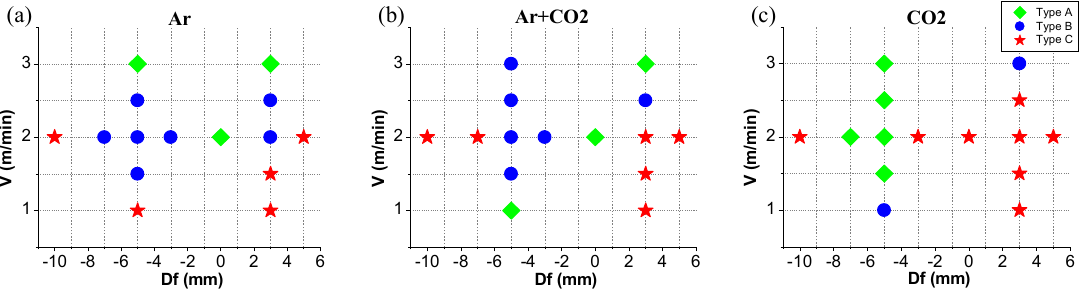
Figure 3. Distribution of weld appearance types under different shielding gases (green diamond is Type A weld joint, blue dot is Type B, red star is Type C): ( a ) in Ar; ( b ) in Ar + CO 2 ; ( c ) in CO 2 .